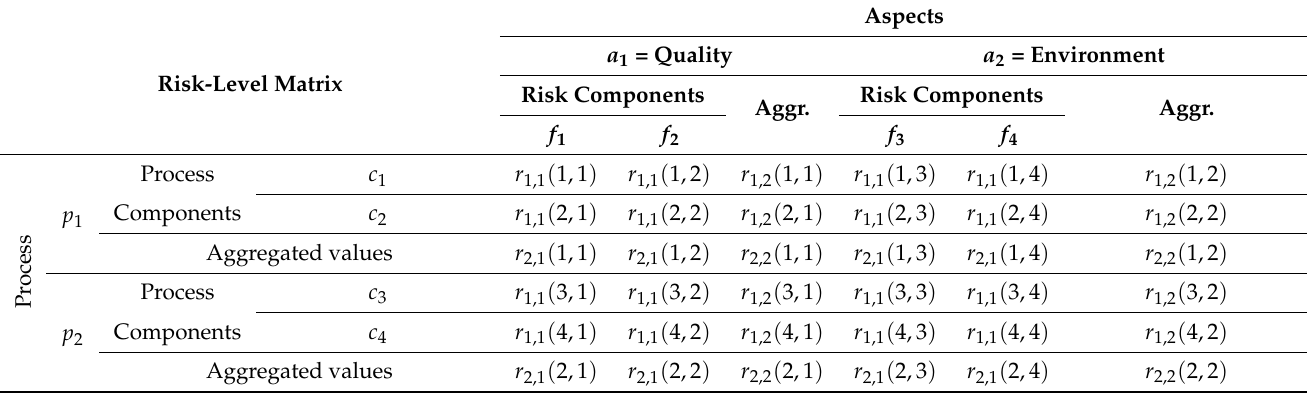
Table 1. The structure of a risk-level